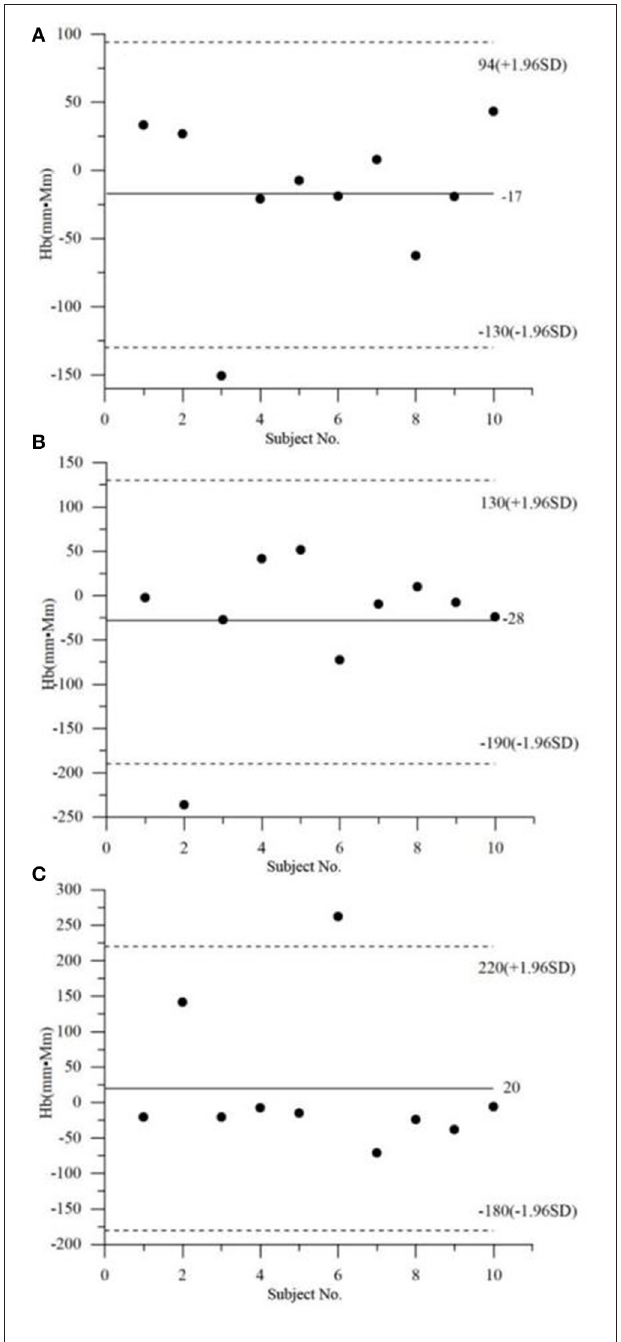
FIGURE 2 | Bland–Altman analysis of the Oxy integral values (i.e., area of the Oxy curve) by the non-task, in the three groups, i.e., (A) MD, (B) HC, and (C)